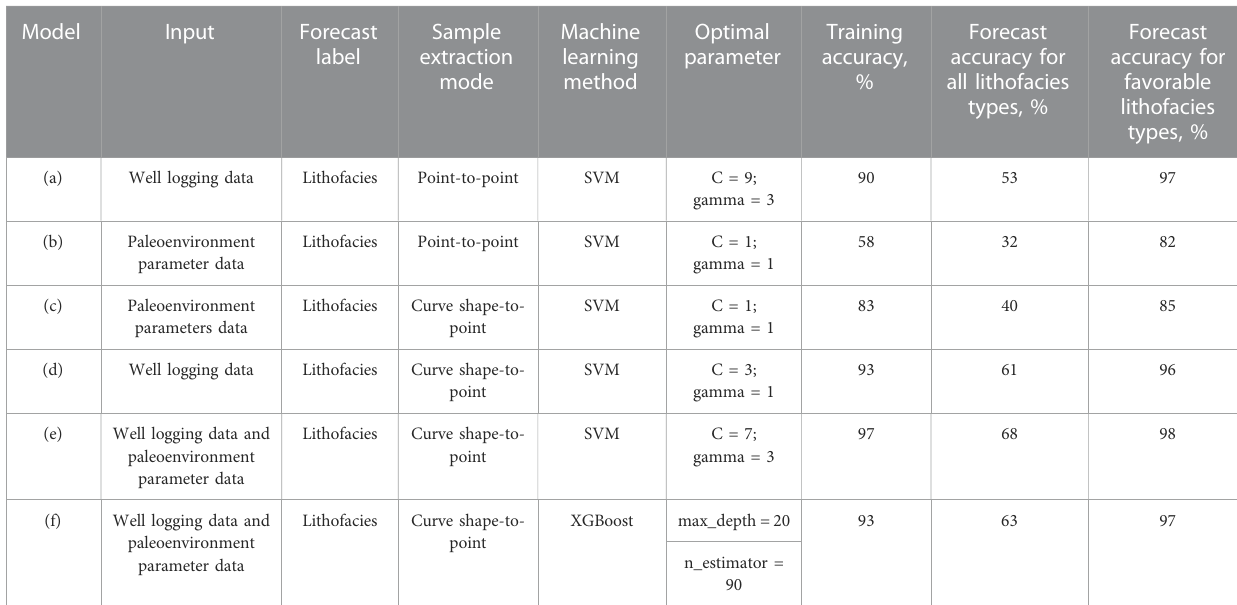
TABLE 1 Comparison of machine learning results for different modeling